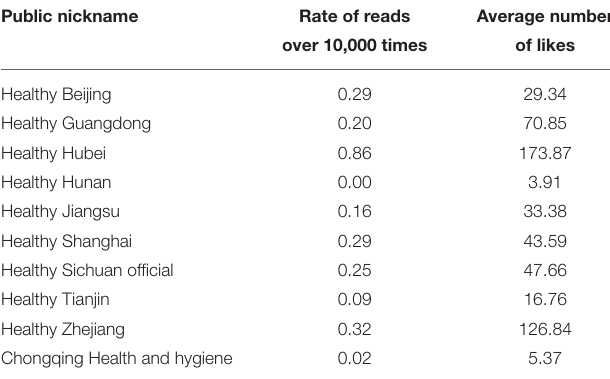
TABLE 3 | Reading in the number of the statistics